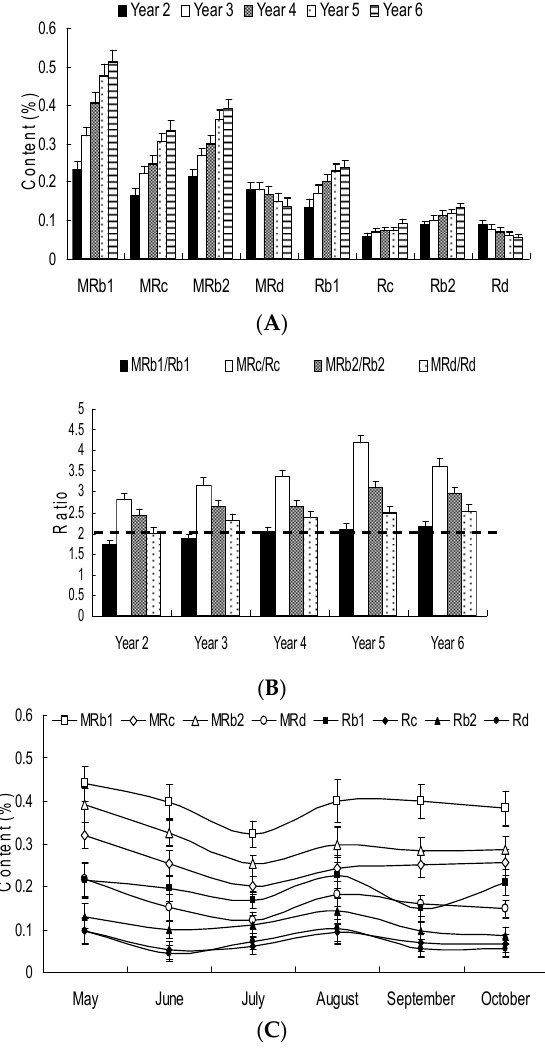
Figure 4. ( A ) Changes in the protopanaxadiol-type ginsenosides contents in the Panax ginseng root according to the cultivation year; ( B ) Ratios of malonyl ginsenosides and their corresponding neutral ginsenosides in different cultivation years; ( C ) Changes of protopanaxadiol-type ginsenosides in Panax ginseng root with different collection month.